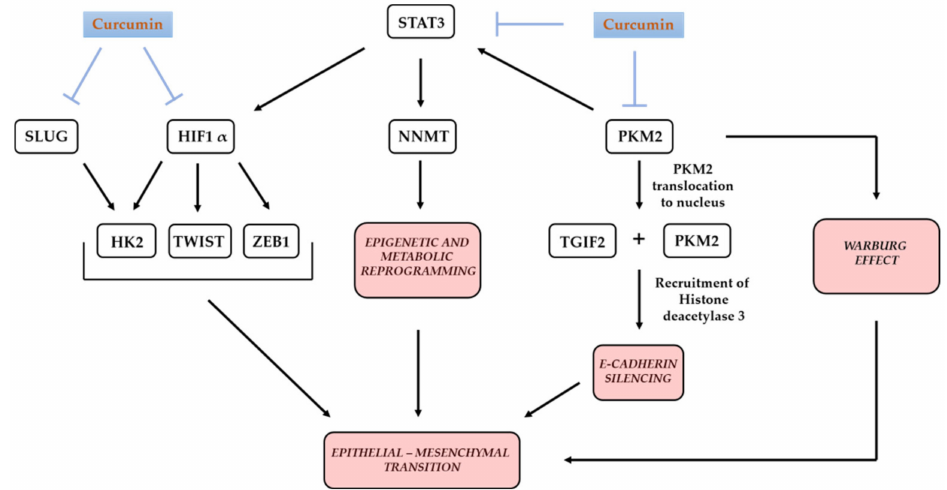
Figure 5. Simplified presentation of an inhibitory e ff ect of curcumin on key molecular players at the cross-roads of epithelial-to-mesenchymal transition and metabolic reprogramming in cancer cell. Curcumin-Mediated Suppression of NNMT and Other Metabolic Enzymes in